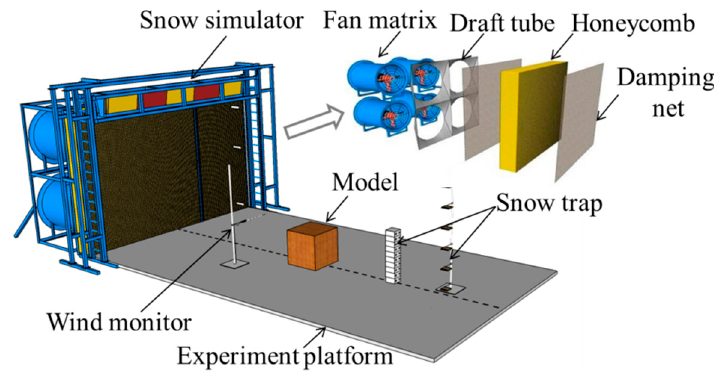
Figure 2. Schematic view of the snow–wind combined experiment facility.